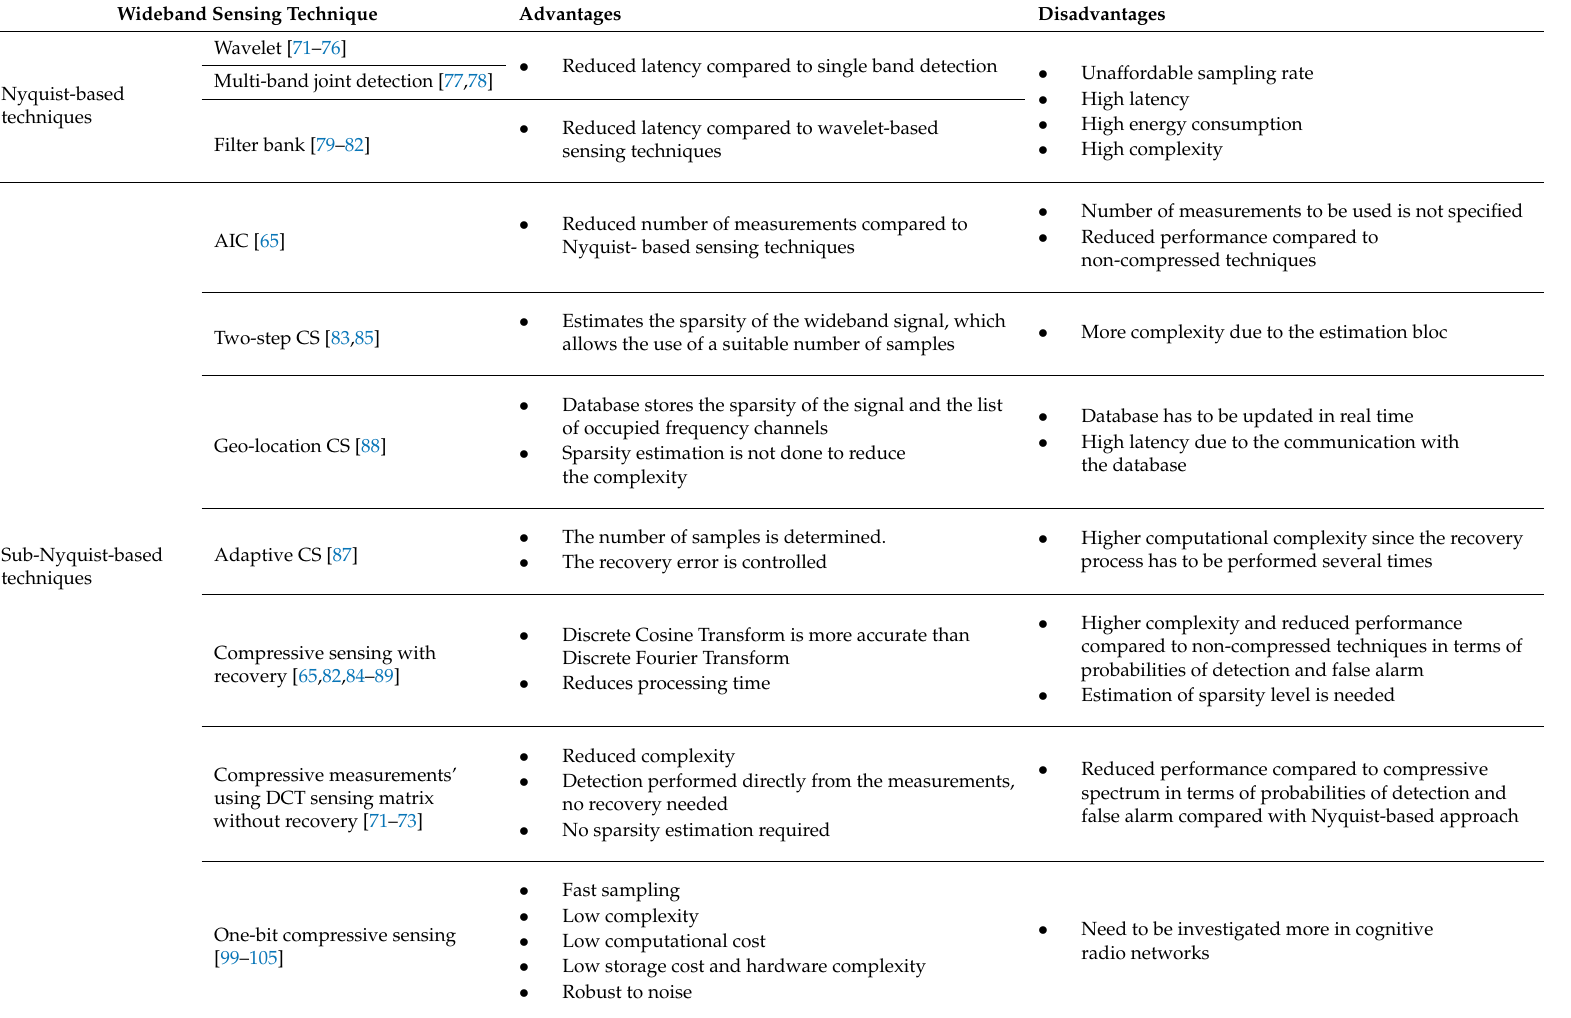
Table 4. Advantages and disadvantages of wideband sensing